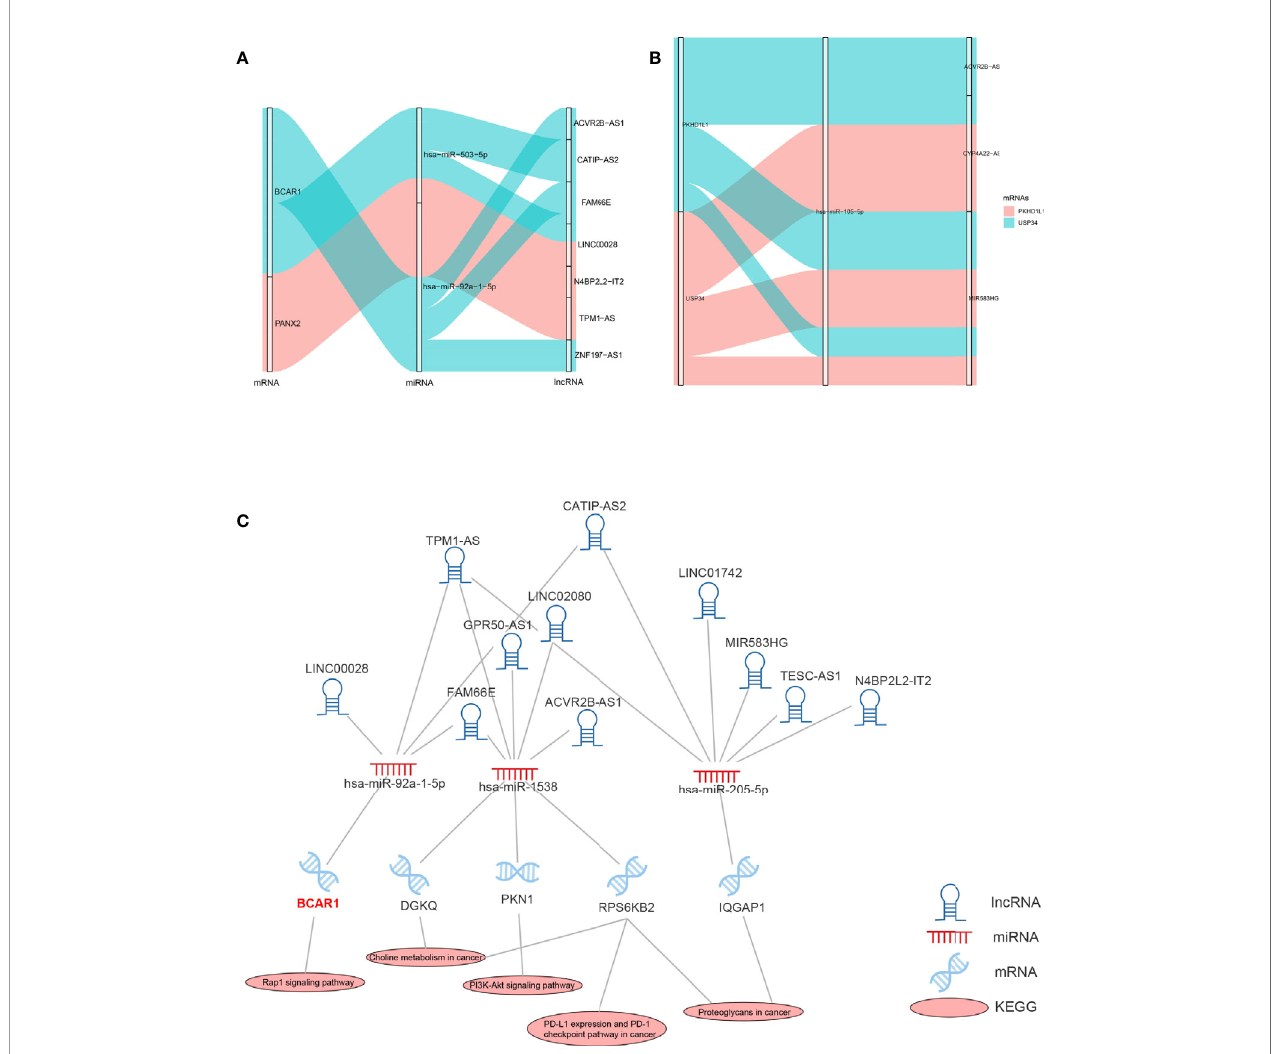
FIGURE 10 | Regulatory mechanism of hsa-miR-105-5p, BCAR1 and PANX2. Sankey diagram shows the regulatory mechanism of BCAR1 and PANX2 (A) . Sankey diagram shows the regulatory mechanism of hsa-miR-105-5p (B) . Cancer associated KEGG pathways shows the regulatory mechanism of BCAR1 (C)